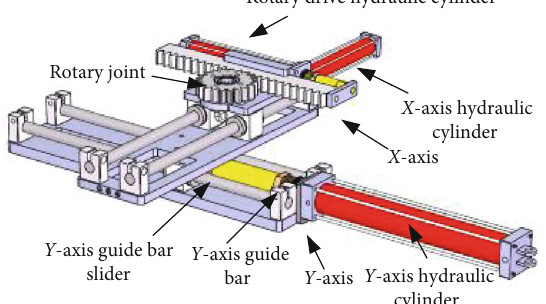
Figure 5: The breast interventional robot positioning mechanism and revolute joint connection.